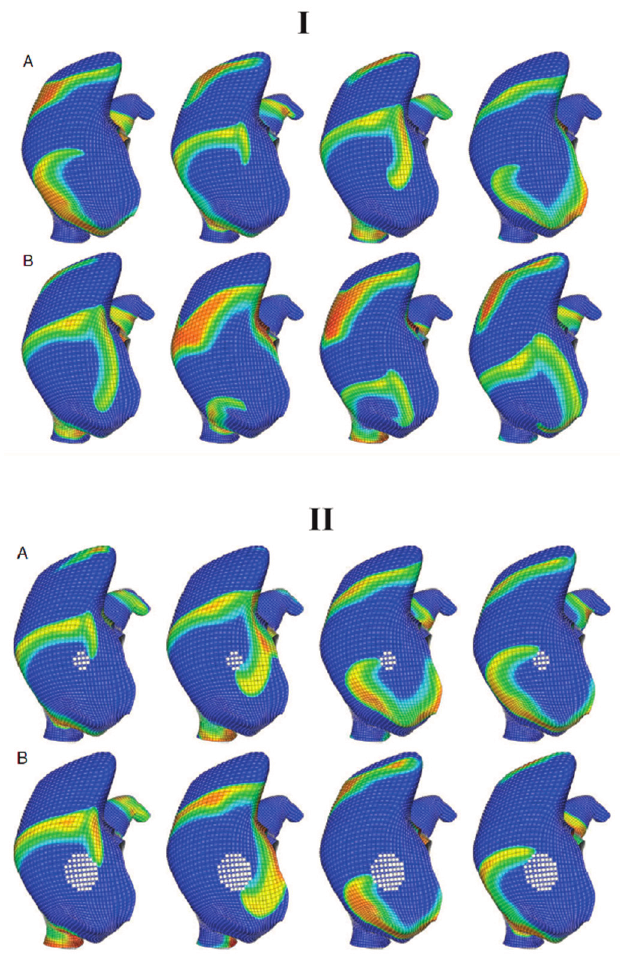
Figure 5. Fiber discontinuities and fibrosis were demonstrated for sustaining rotors using a computer model based on computed tomography (CT) imaging of a patient with a history of persistent AF [51]. ( I ) Fiber discontinuities (white lines) help to initialize ( A ) and stabilize a meandering rotor ( B ); ( II ) Structural remodeling, fibrosis (white area), near the rotor core converted meandering rotor to stable macro-reentry rotor. ( A ) The rotor initially meandered around the fibrotic region and eventually became sustained; ( B ) After the diameter of the fibrotic region was increased, the rotor was still stable but had reduced rotational frequency. Reprinted from [51] with permission from Oxford University